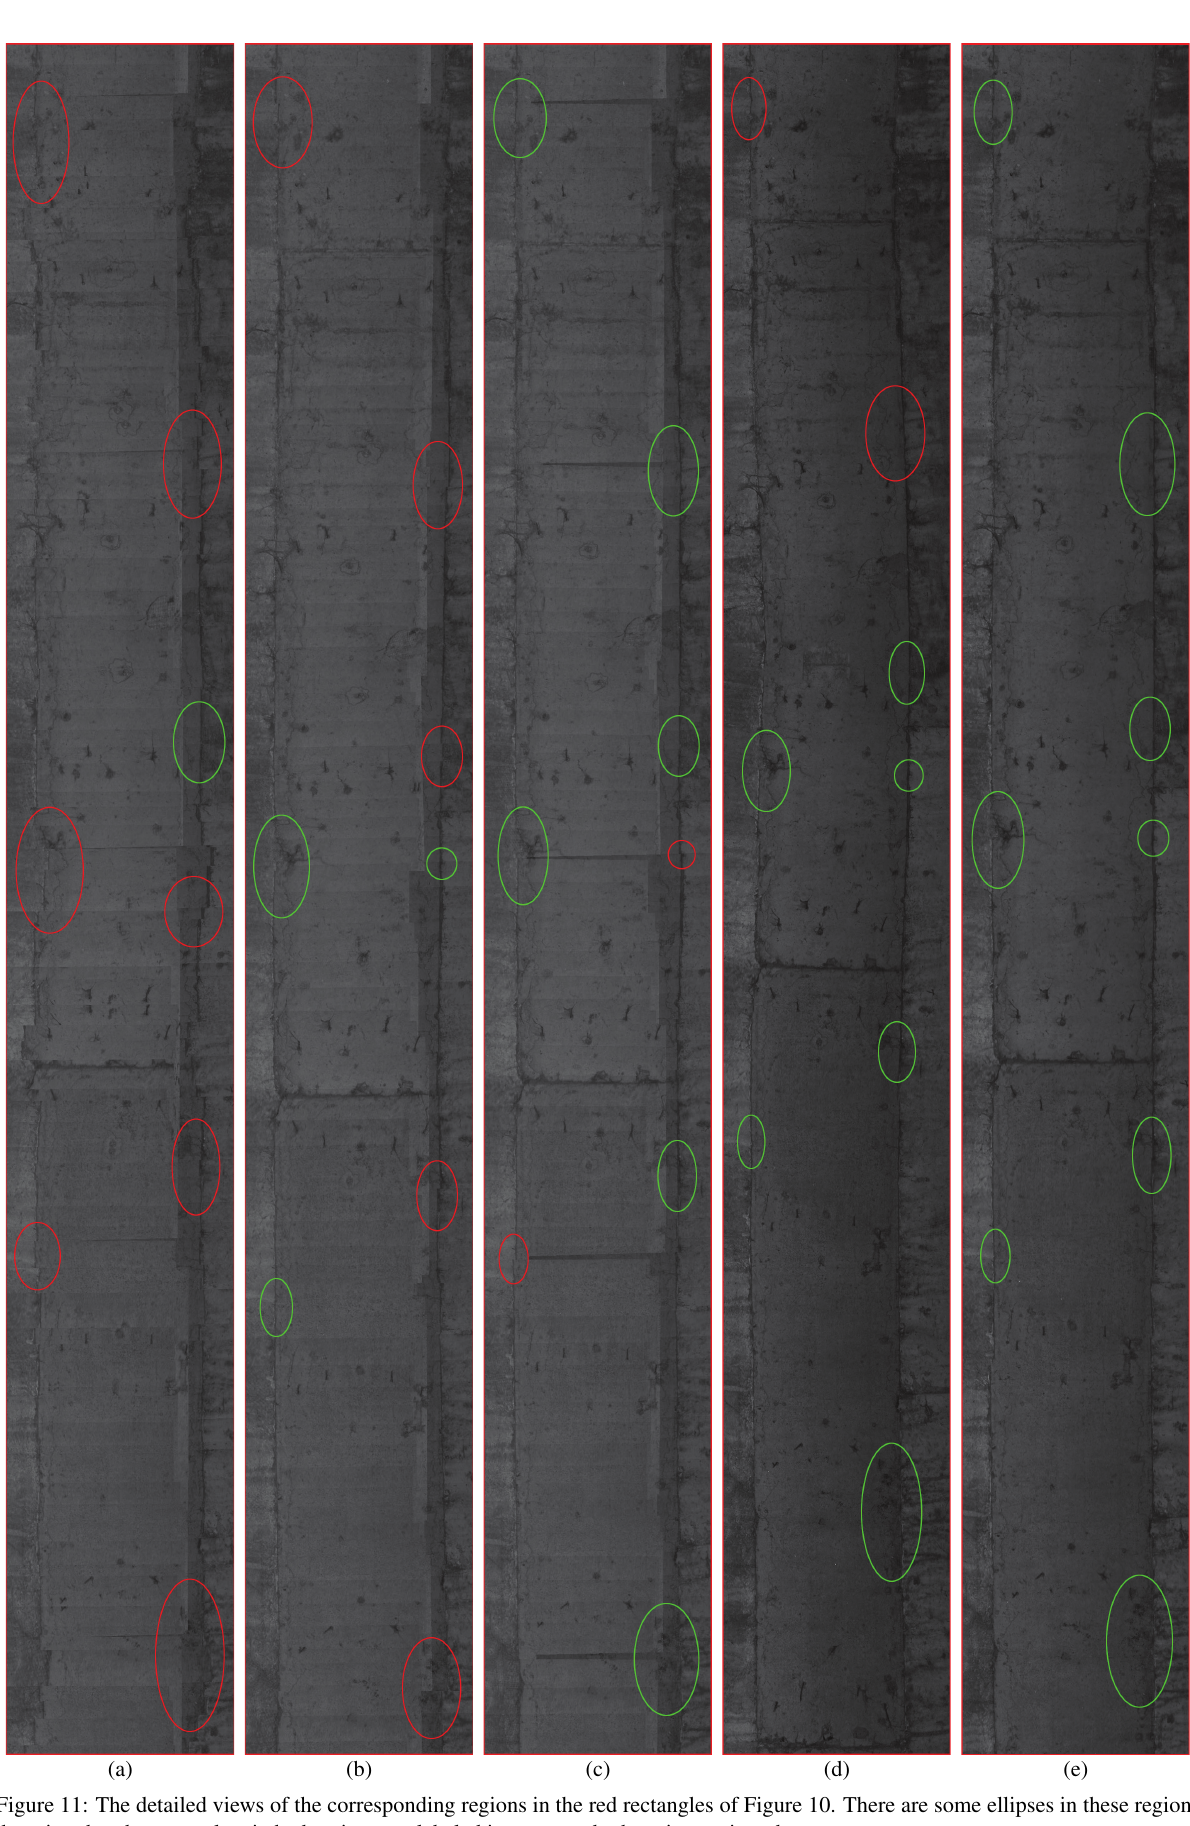
Figure 11: The detailed views of the corresponding regions in the red rectangles of Figure 10. There are some ellipses in these regions denoting that the correctly stitched regions are labeled in green and otherwise are in